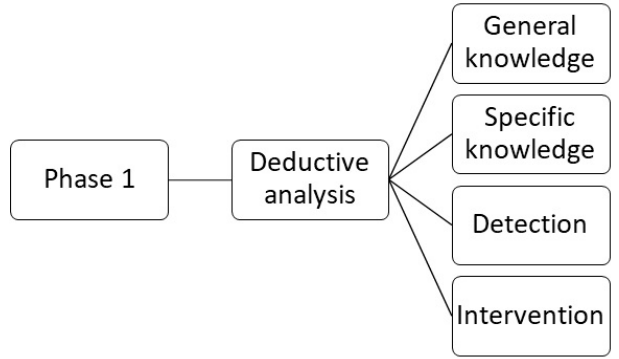
Figure 1. First phase of the analysis.